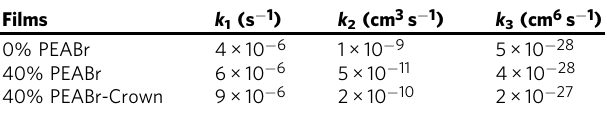
Table 1 Fitted recombination rate constants from TA measurement for perovskite fi lms of different composition